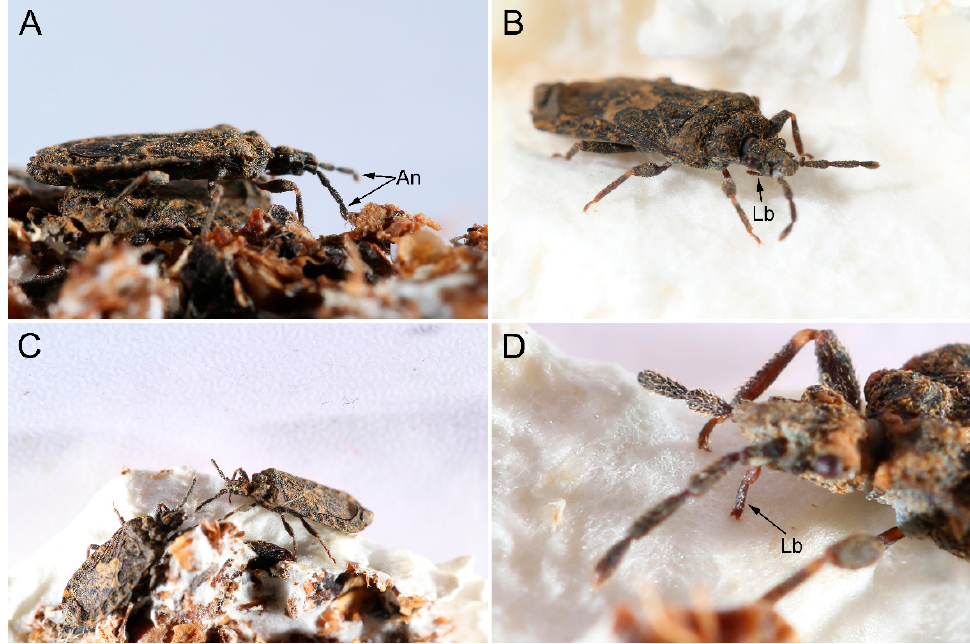
Figure 9. Feeding process of Mezira yunnana . ( A ) Swaying antennae; ( B ) orienting by rostrum; ( C ) feeding on a fruiting body; ( D ) enlarged view showing the position of the labial tip. An, antennae; Lb, labium.